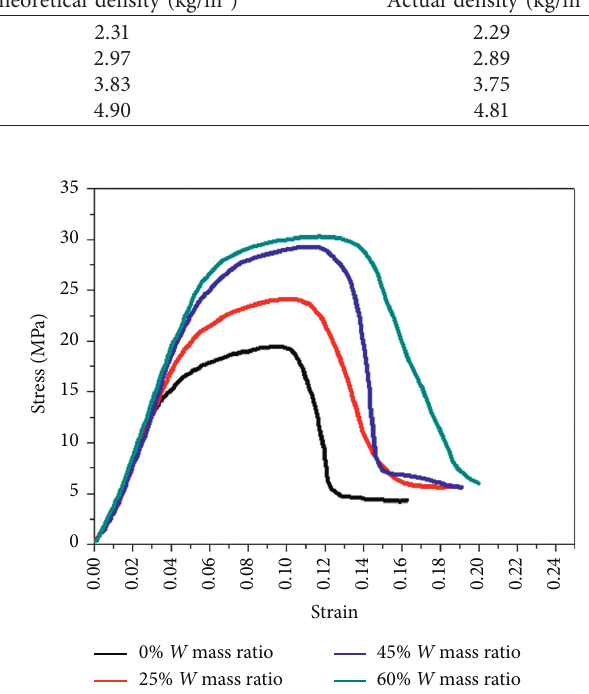
Figure 3: Quasistatic compressive stress-strain curves of the Al/ PTFE/W energetic